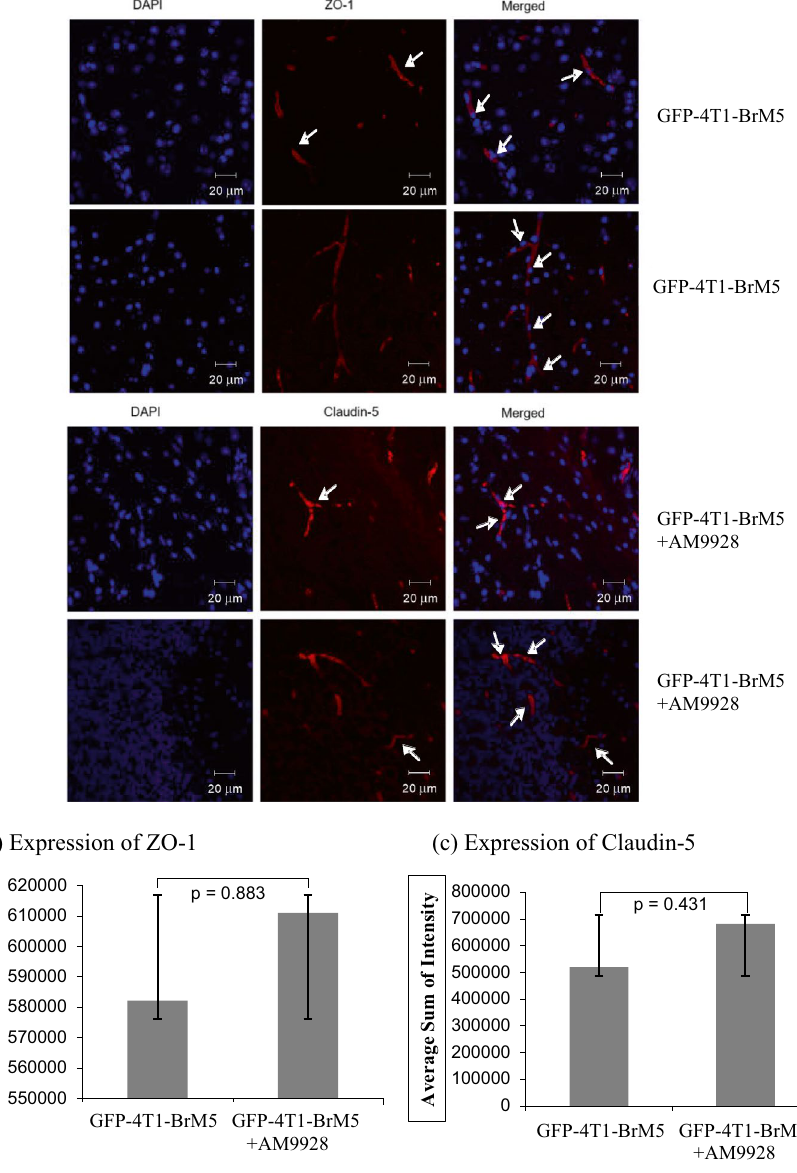
Figure 6. ( a ) Analysis of ZO-1 and Claudin-5 expression in the BBB in mice treated with AM9928: Fluorescence Texas Red was used as a secondary antibody to detect ZO-1 and Claudin-5 expression in mouse brain tumor sections. ZO-1 and Claudin-5 structures (red) are shown by arrows, as indicated. Brain nuclei were counterstained with DAPI (blue). These are representative images of over 50 fields examined from three independent experiments. The magnification—× 40; scale bar-20 μm. ( b ), ( c ): Quantitative analysis of Claudin-5 and ZO-1 proteins expression in the brain in mice treated with AM9928: The expression level was quantitated and compared with GFP-4T1-BrM5 injected mice and mice treated with vehicle control. Changes in BMEC-TJ proteins in brain section samples after AM9928 treatment as compared to BMEC-TJ proteins from control mice is shown. Data are presented as the mean ± S.D. of two experiments. Number of mice per group per treatment, n = 10. Scale bar = 20